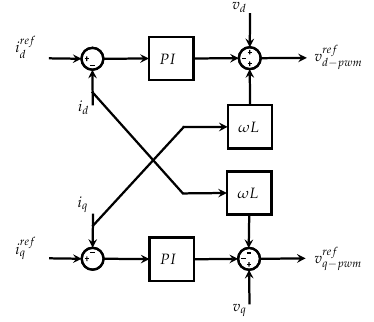
Figure 4. Current control block